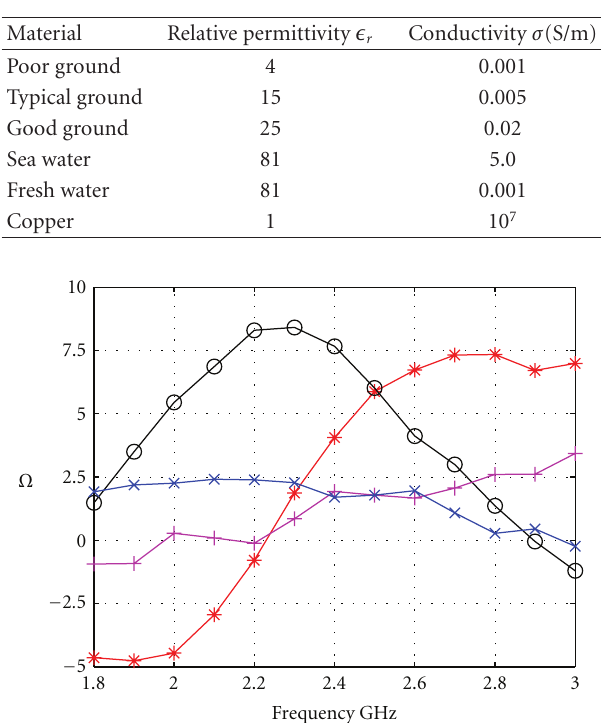
Table 1: Ground material parameters used in Figure 2 [16].